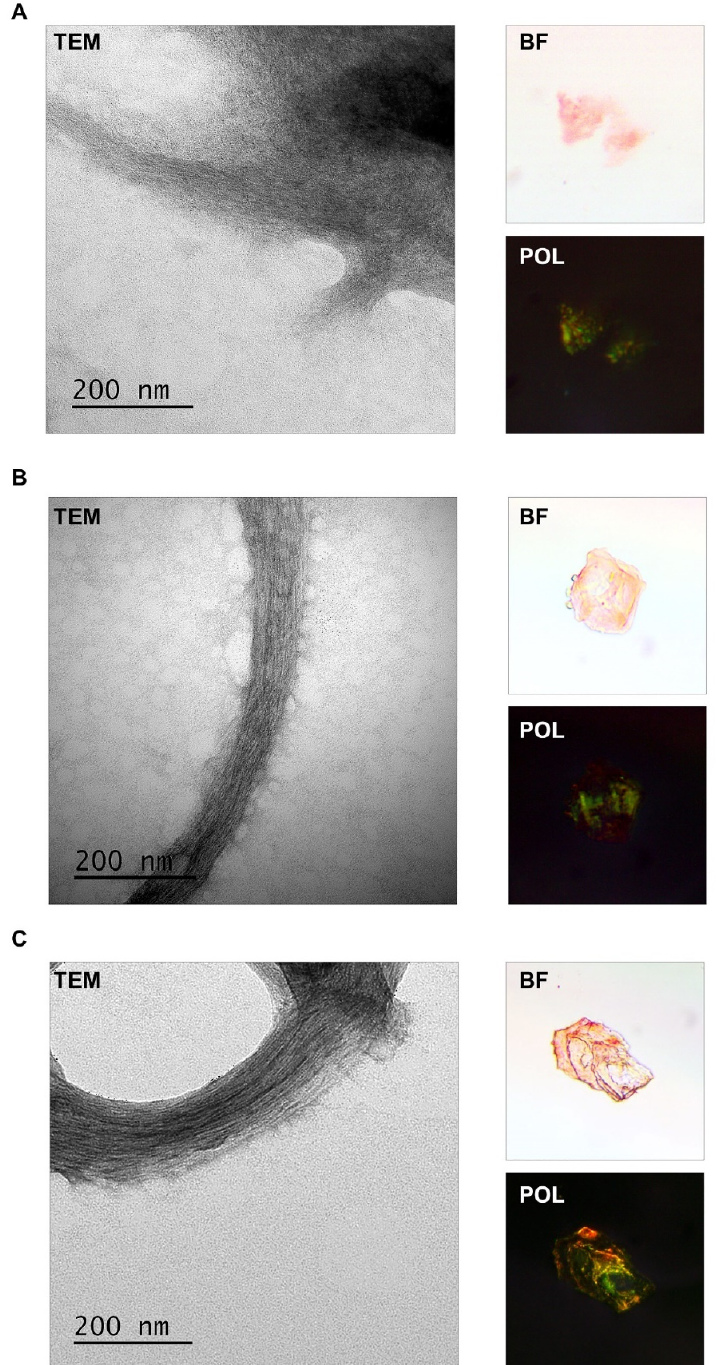
Figure 4. Analysis of the fibrillar structure and CR staining of the FXR1 protein isolated from the brain of Xenopus laevis ( A ), Trachemys scripta ( B ), and Gallus gallus domesticus ( C ). FXR1 after immunoprecipitation was detected using TEM. CR staining was analyzed in transmitted (BF) and polarized (POL)